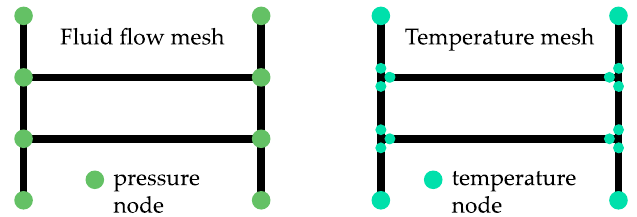
Figure 3. Comparison of the fluid flow mesh (left) and the temperature mesh (right). The fluid flow mesh consists of 8 edges with 8 nodes total, and there are 8 unknown pressures (in the green nodes, some of which are shared between edges); in the temperature mesh, there are 2 × 8 = 16 nodes and, therefore, 16 unknown temperatures.